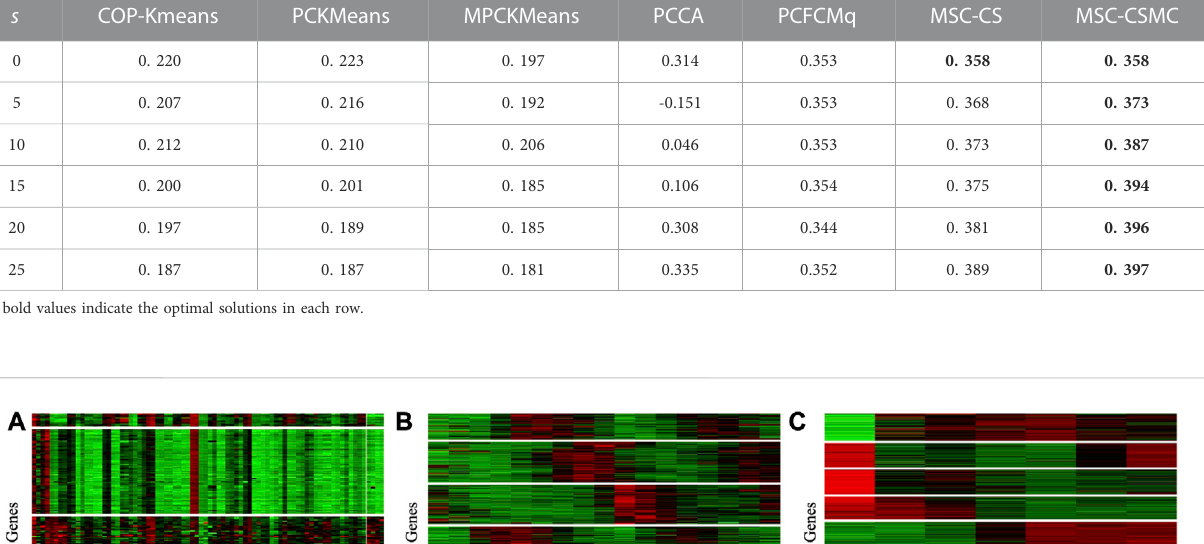
TABLE 6 SI values on Arabidopsis with different number of constraints.